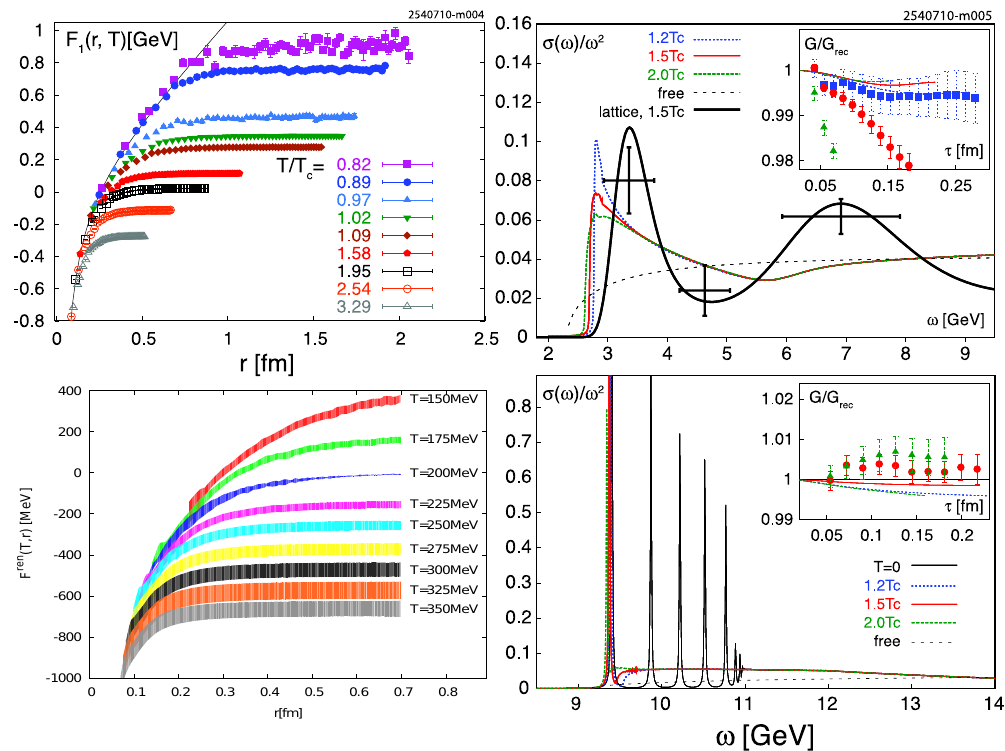
Figure 6. Left : Heavy-quark-singlet free energy versus quark separation calculated in 2 + 1 flavor QCD for ( top ) different values of T / T c [116] and ( bottom ) continuum-extrapolated values of the static Q ¯ Q free energy for different temperatures [117]. The solid black line on the right top plot is a parameterisation of the zero temperature potential; Right : The S-wave ( upper ) charmonium and ( lower ) bottomonium spectral functions calculated in potential models. Insets: correlators compared to lattice data. The dotted curves are the free spectral functions. Reproduced from Ref.